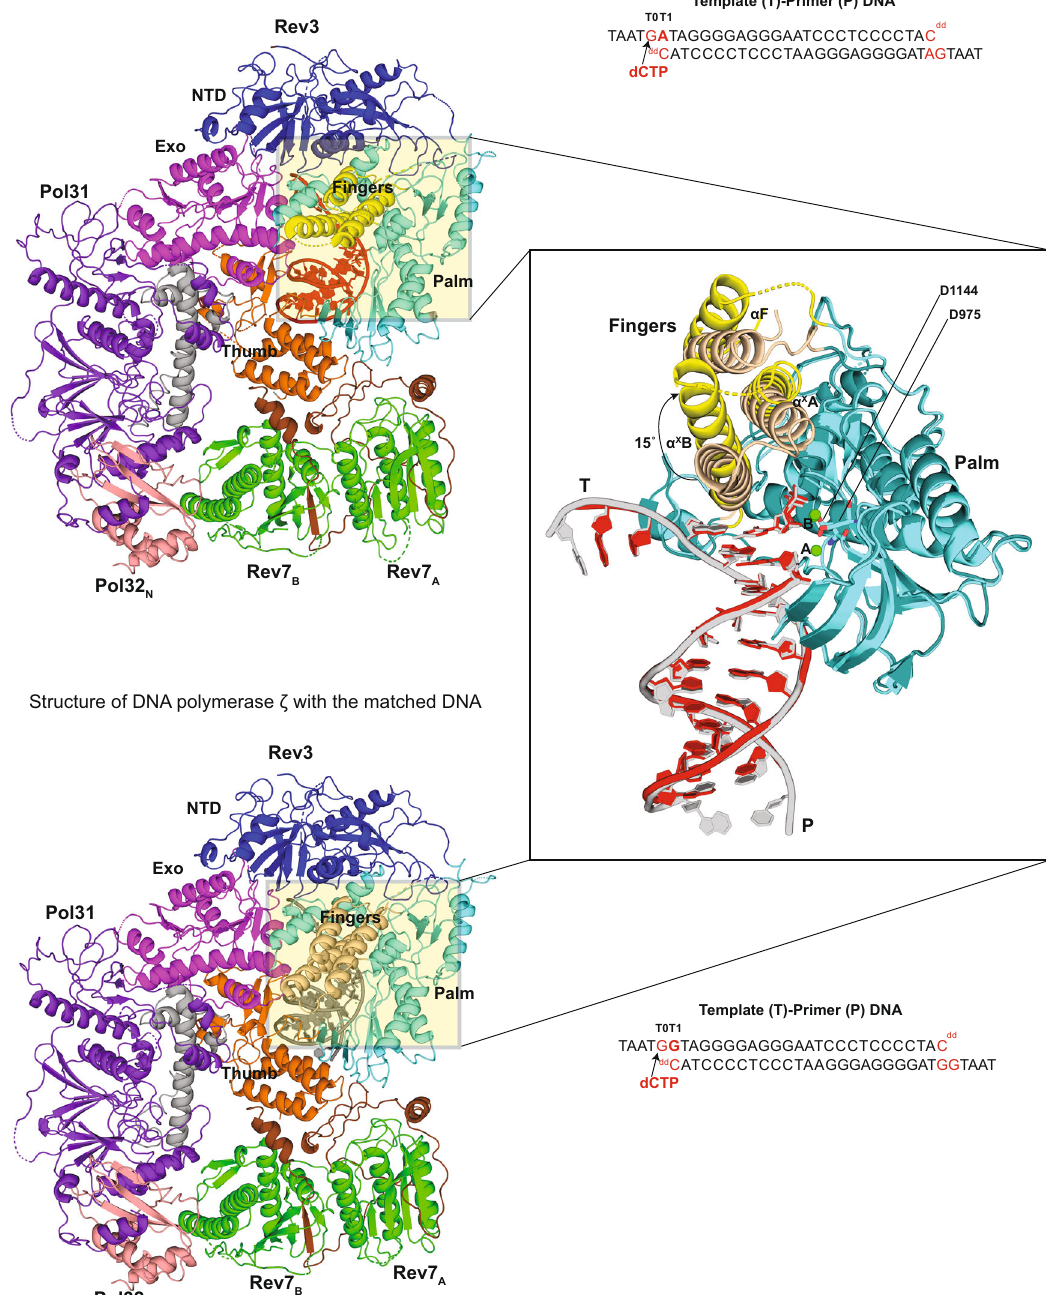
Fig. 1 Structure of mismatched (A:C) DNA-Pol ζ ternary complex. For the mismatched (A:C) DNA-Pol ζ ternary complex, the NTD (N-terminal domain), Exo (Exonuclease), RIR (Rev7 interacting region), fi ngers, palm, thumb, CTD (C-terminal domain) of Rev3 are shown in blue, magenta, brown, yellow, cyan, orange, and light gray, respectively; Rev7 A and Rev7 B in green; Pol31 and Pol32 N in purple and salmon, respectively; and the DNA and incoming dCTP in red. For comparison, the matched (G:C) DNA-Pol ζ ternary complex 7 (PDB ID: 6V93) is shown below following the same color scheme, except for the fi ngers domain depicted in wheat color and the DNA and incoming dCTP in gray. The fi gure also displays the palindromic template-primer DNA sequences and the dCTP used to reconstitute the ternary complexes with Pol ζ . The right panel displays a close-up view of the region around the DNA, upon an ~90° clockwise rotation of the structure along the y-axis, depicting the fi ngers helices α F, α x A, and α x B in a closed (matched DNA complex) and open (mismatched DNA complex) conformation. An arc arrow highlights the ~15 ° outward movement of the fi ngers domain in the mismatched DNA complex relative to the matched DNA complex. Also highlighted in sticks are the active site residues D975 and D1144. Green spheres depict the active site metal B in the mismatched DNA complex and the active site metals A and B in the matched DNA